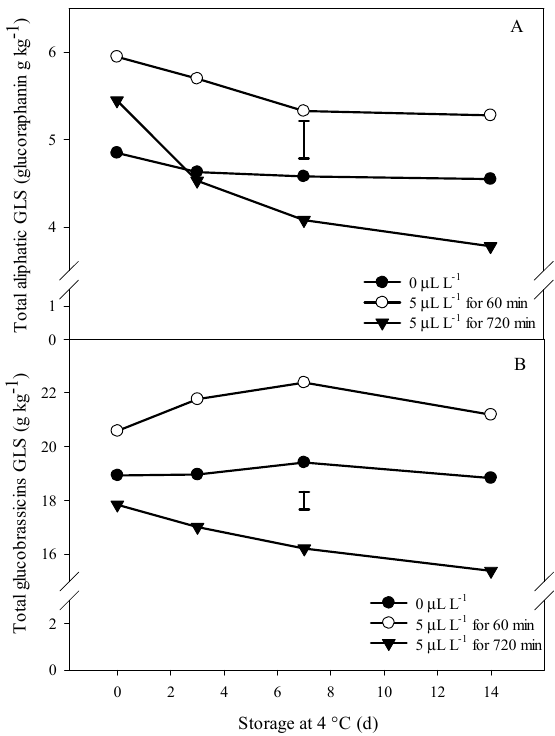
Figure 3. Effect of ozone exposure on total aliphatic and indole-type glucosinolates of broccoli florets. Total aliphatic (glucoraphanin) ( A ) and indole-type ( B ) glucosinolates in broccoli florets exposed to three doses of ozone, 0 µL L − 1 ( ● ), 5 µL L − 1 for 60 min ( ○ ), and 5 µL L − 1 for 720 min ( ▼ ), during storage in the dark for 14 days at 4 °C. Values are g equivalents of sinigrin on a dry weight basis. The bar in each graph represents the LSD value (0.05) = 0.54 ( A ) and 0.76 ( B ).d, day. The same trend was perceived with the individual titers of GLS, where the overall amount of these compounds were more elevated compared to HCA content (Figure 4).